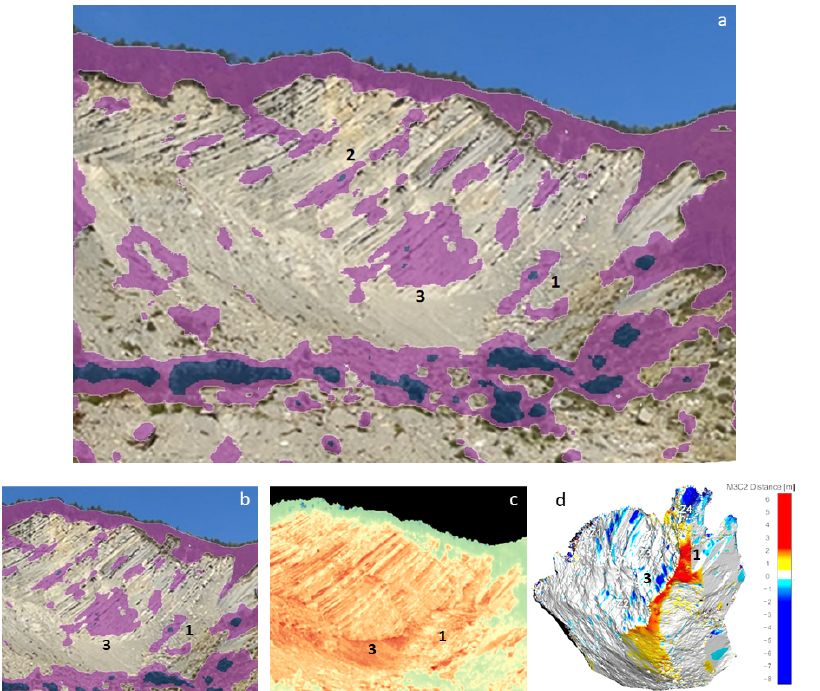
Figure 6. Visible image of the upper scarp with overlapping of multiscale segmentation map in false purple color scale: only the two lowest levels are shown, while the two highest levels are set as a transparent layers. The result is an overlayed map of areas of the rocky scarp with an anomalously low TIR signal, relevant for rockfall hazard monitoring. The lowest level in dark purple almost entirely corresponds to vegetation-covered areas, for which our physical model does not hold, and therefore they should not be considered as relevant areas but rather simply as low TIR reflectance areas. ( b ) Zoom in of a detail in the image ( a ), ( c ) the same FOV of image ( b ) in false color in TIR range, ( d ) a stroboscopic point-cloud performed by UAV photogrammetry, image from [36].